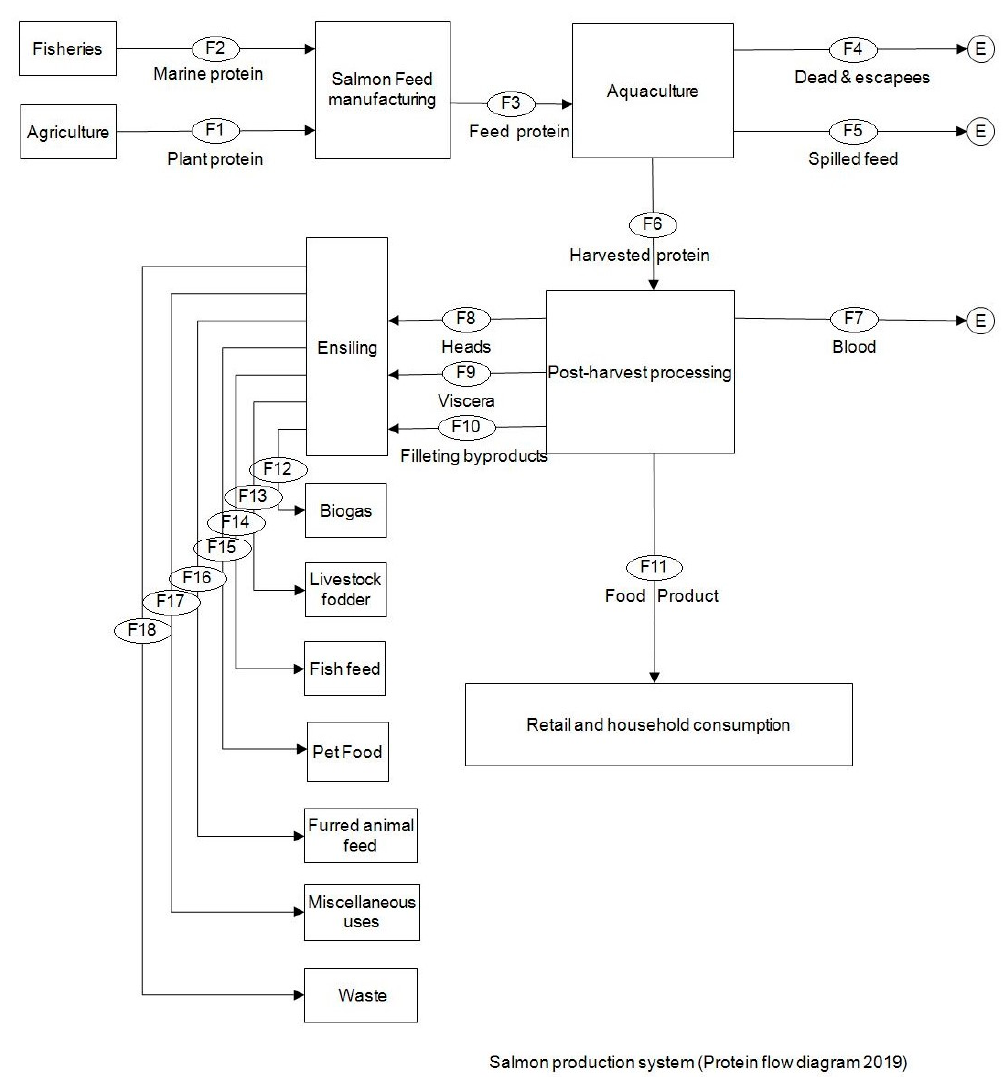
Figure 1. Processes and flows map. Table 3. Calculated annual protein flows in 2019